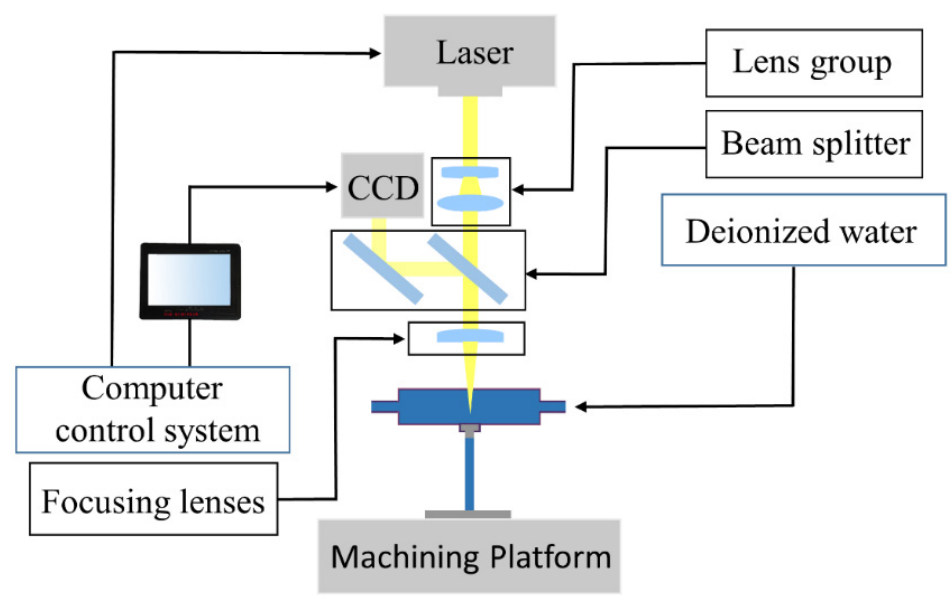
Figure 2. Schematic diagram of the water-jet-guided laser processing platform.